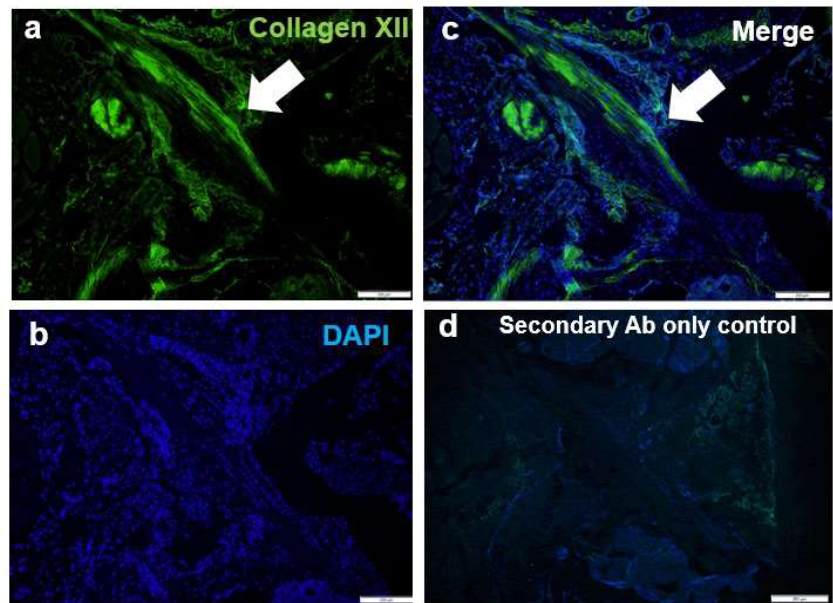
Figure 3. Collagen XII immunofluorescence in the ACL. Immunofluorescence of collagen XII was detected (arrows) in ACLs of 17-week-old wild-type mice. ( a ) Collagen XII is represented by green fluorescence. ( b ) Nuclei were visualized by DAPI staining (blue). ( c ) Merged images. ( d ) Secondary antibody only was used as a staining control. Bars = 200 µm.